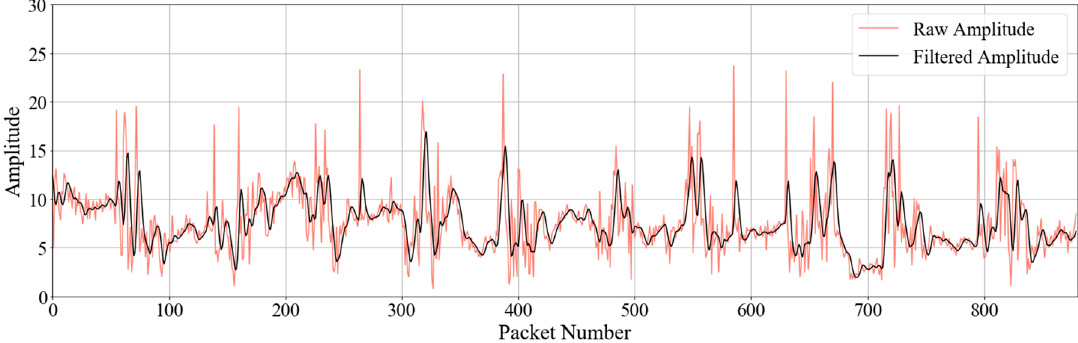
Figure 4. Comparison of raw and filtered amplitude data for one subcarrier.